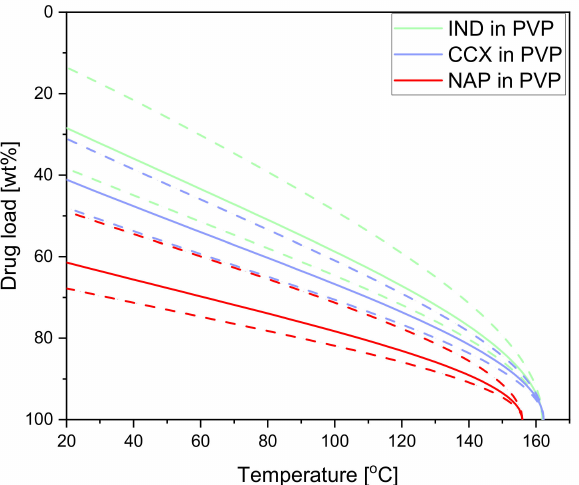
Figure 3. (Predicted) drug solubility curves for IND in PVP (green), CCX in PVP (blue) and NAP in PVP (red). Dashed lines indicate the confidence interval. The data for IND and CCX in PVP was taken from [28].